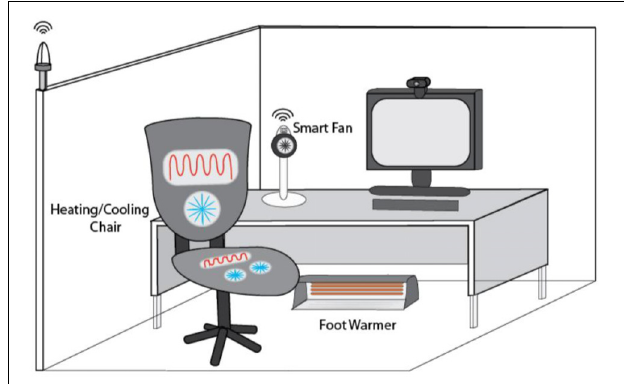
FIGURE 6 | Personal comfort systems (PCS) help resolve the unaddressed gaps of HVAC